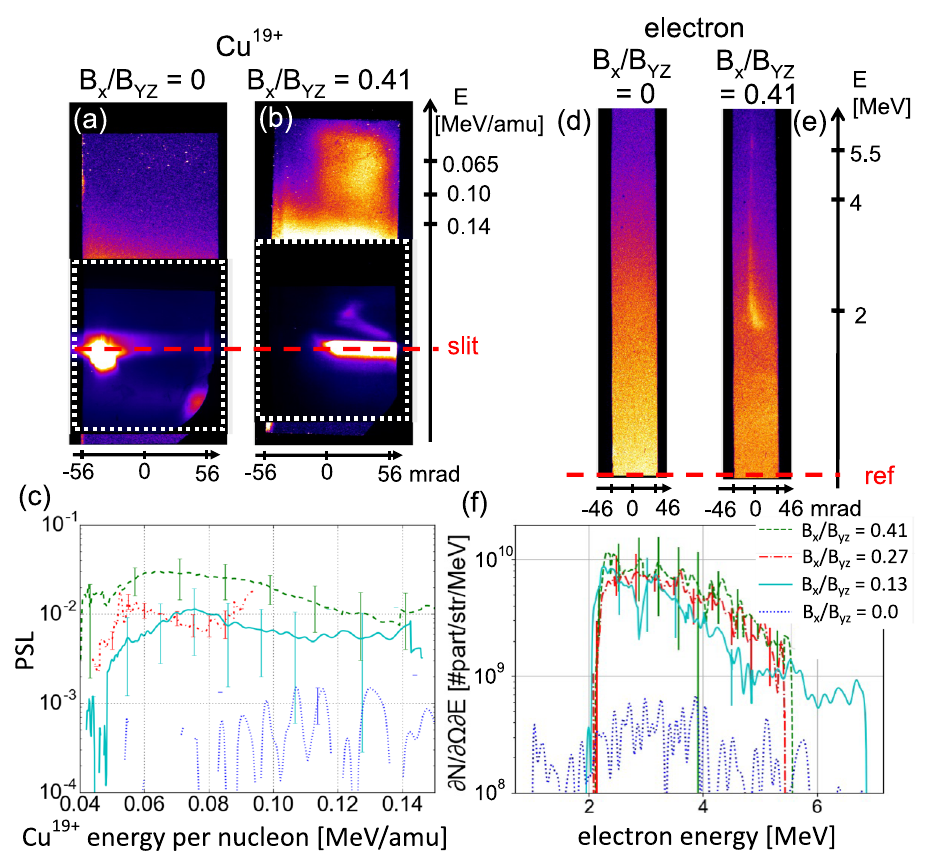
Fig. 3 | Laboratory evidence for enhanced particle acceleration along the cur- rentsheetinthepresenceofaguide fi eld. RawspectraofCuionsasrecordedby the particle spectrometer in the absence ( a ) or presence ( b ) of a guide fi eld. Since the T2 and T3 targets are madeofCopper,note thatwe made the assumption that the ions recorded in the spectraare Cu 19+ , based on the average ionization state we expect to have in our plasma conditions. The vertical axis is the spectral one, the horizontal one is sampling the angle of emission of the particles from the targets. For panel b , we have B x / B yz =0.41. In the region surrounding the projection of the spectrometer entrance slitonto the detector, the images are strongly saturated by the X-ray and visible light emitted from the plasma. This is why the images shown are a patch of the fi rst scan of the image plate detector (top part) where the ion signalcanbeseen,withthesecond,unsaturatedanddelimitedbythewhitedashed